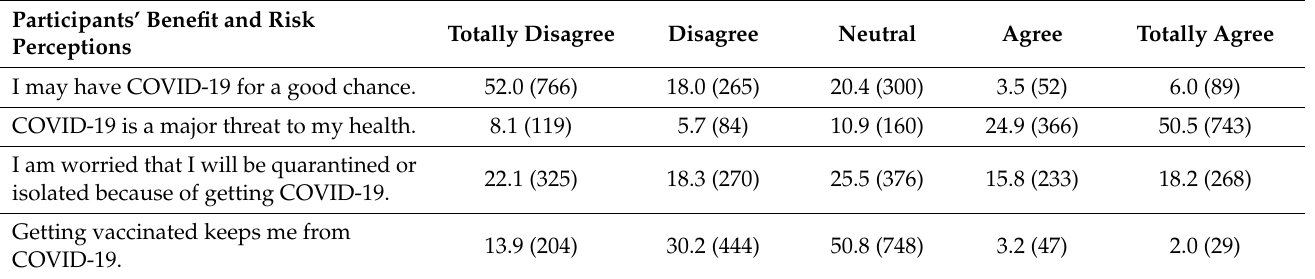
Table 4. Participants’ benefit and risk perceptions ( n = 1472).